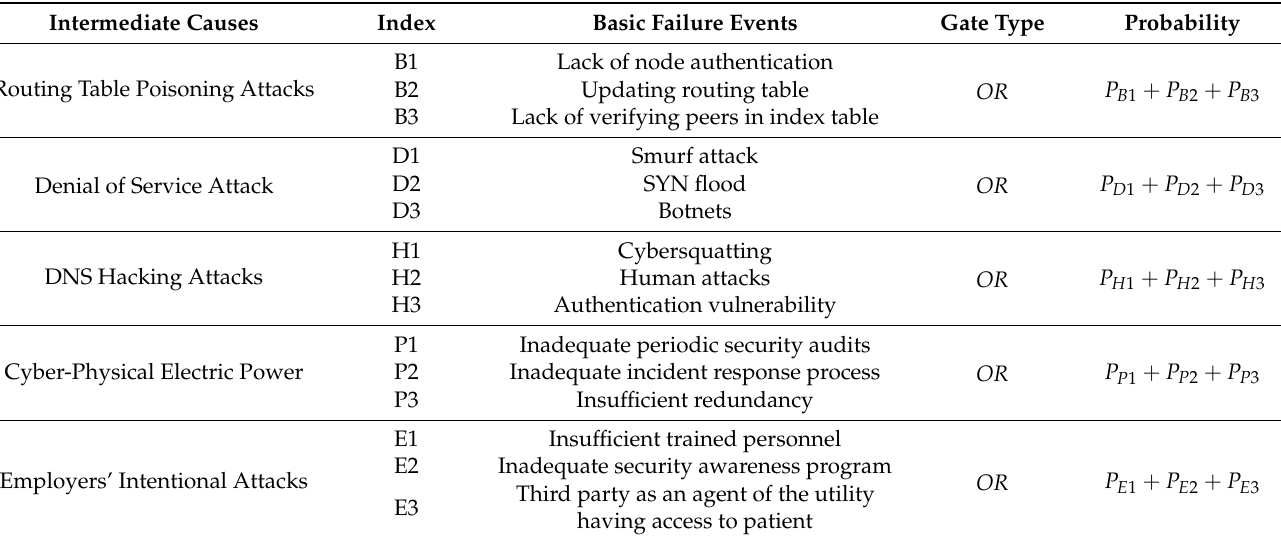
Table 4. Probability of causes that lead to cyberattacks in